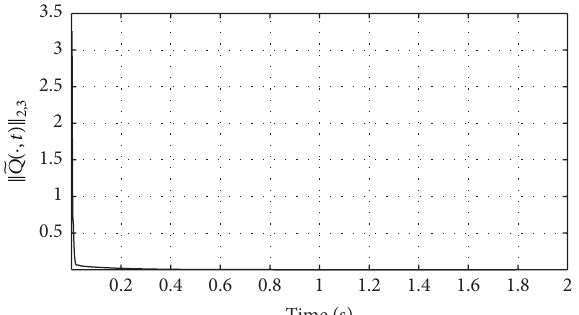
Figure 3: Temporal evolution of the norm